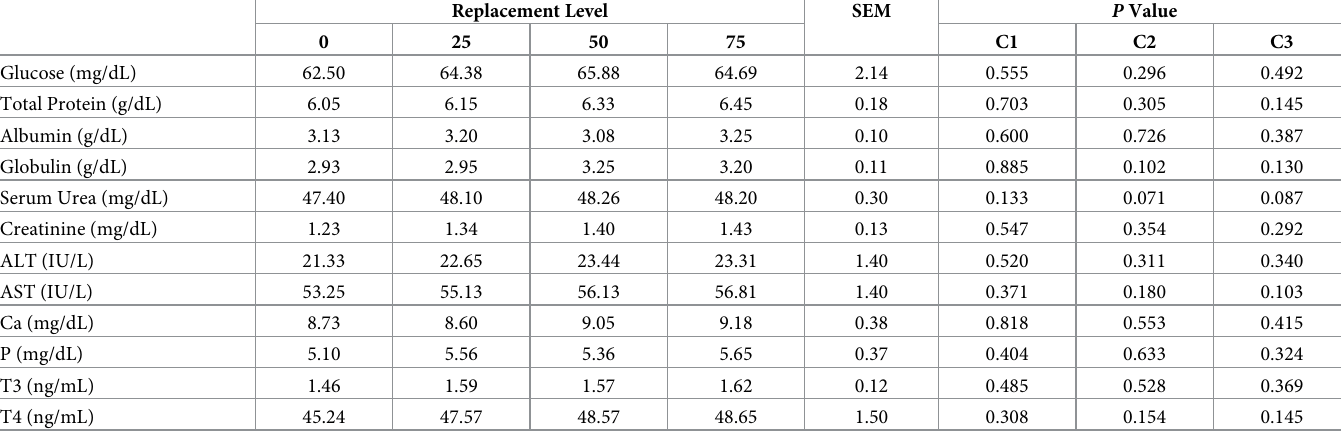
Table 4. Effect of replacing soybean meal with SRU on biochemical constituents and endocrinal responses of adult rams. Replacement